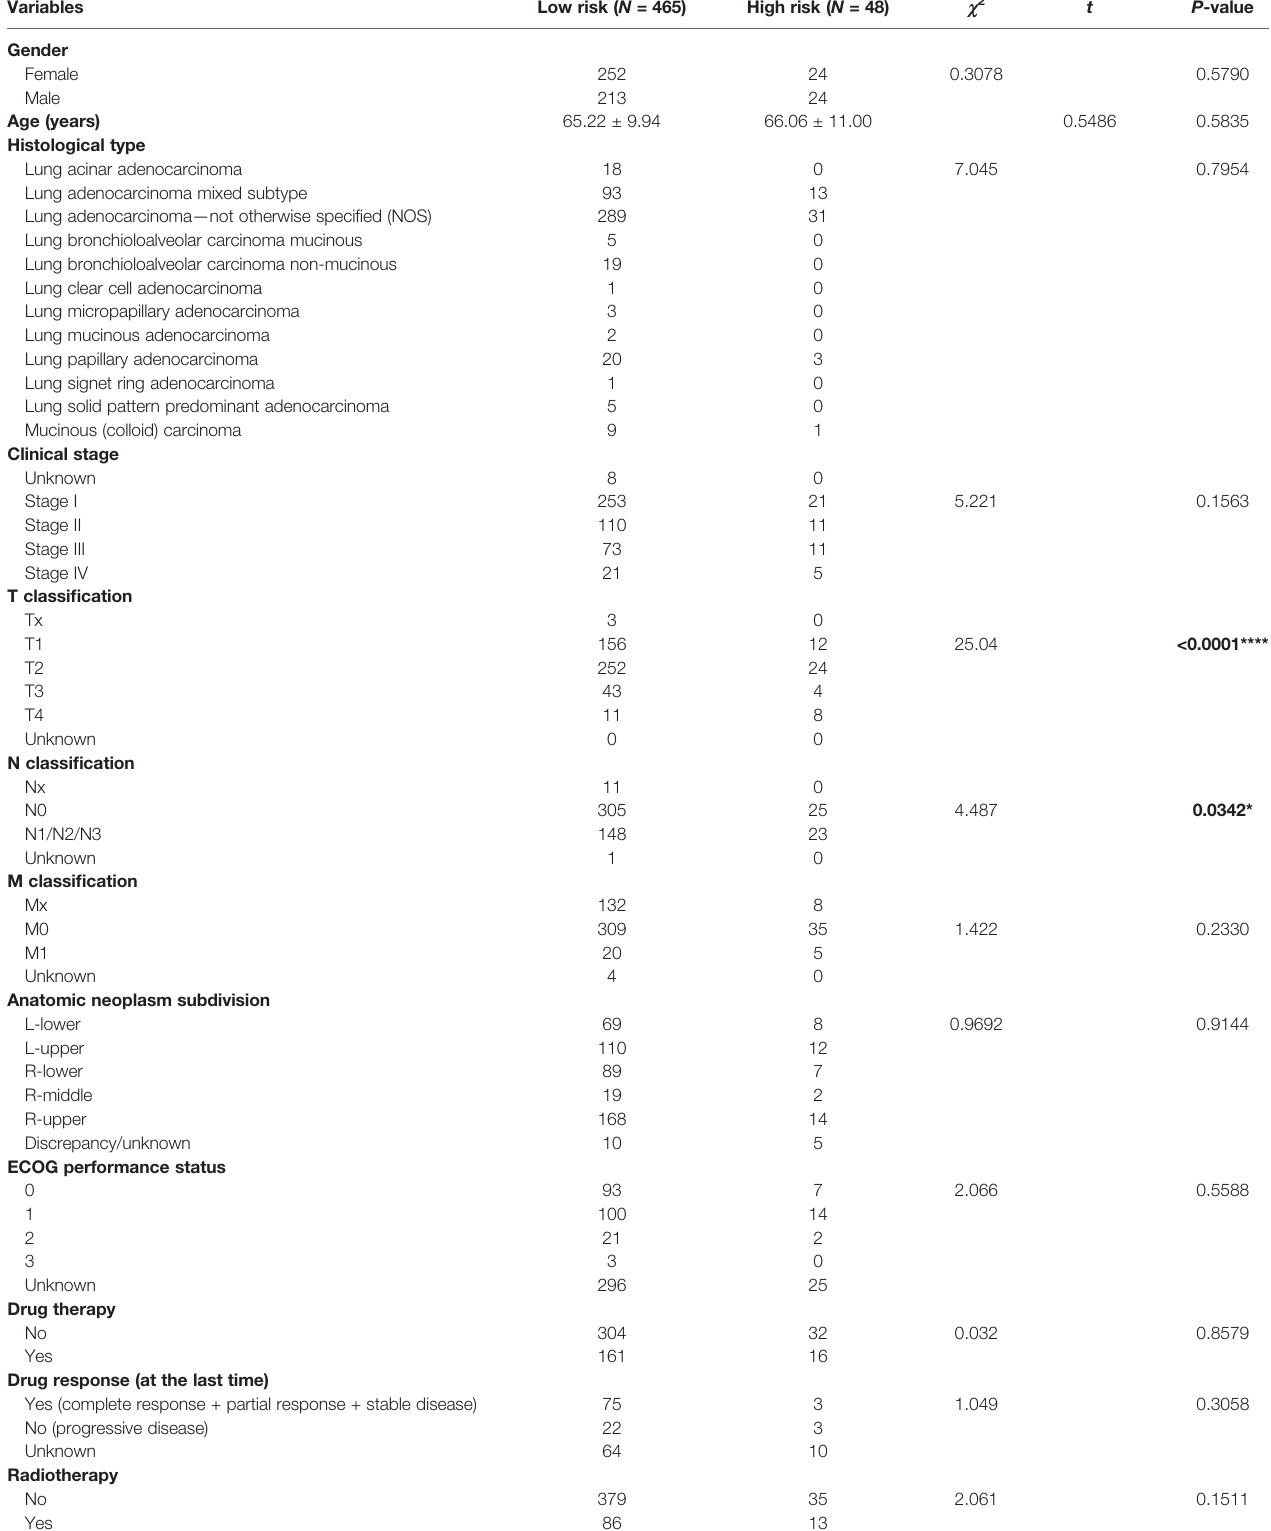
TABLE 1 | Correlation between LARSO and the clinicopathological characteristics of lung adenocarcinoma patients in the TCGA database ( N =